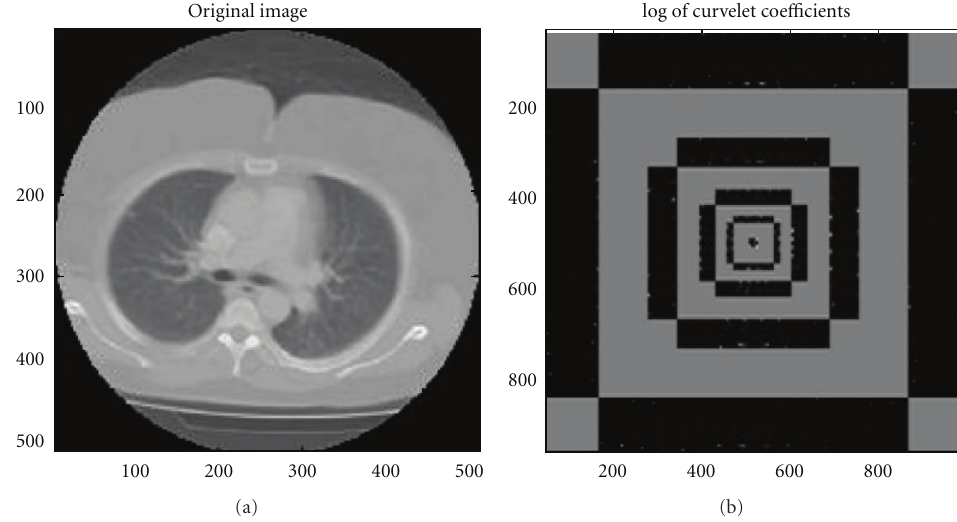
Figure 12: Clinical slice for the human chest from a CT scanner in spatial (a) and curvelet coe ffi cients (b).